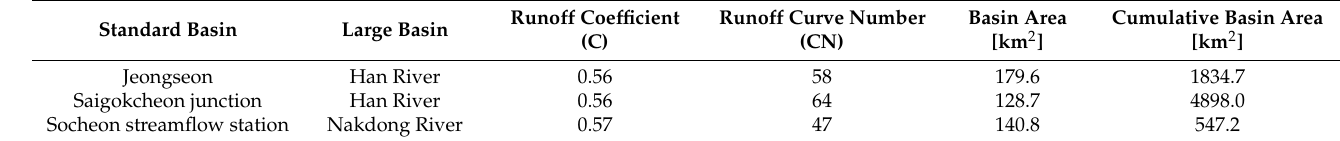
Table 2. General characteristics of basins (Reprinted from [8]).